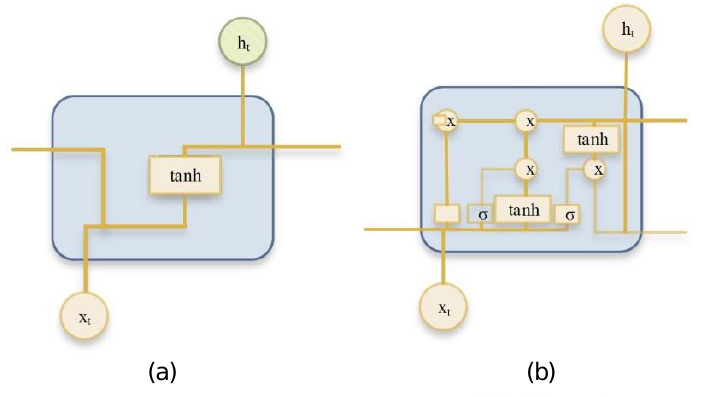
Figure 2. The structure of RNN and LSTM. ( a ) the structure of RNN unit; ( b ) the structure of LSTM